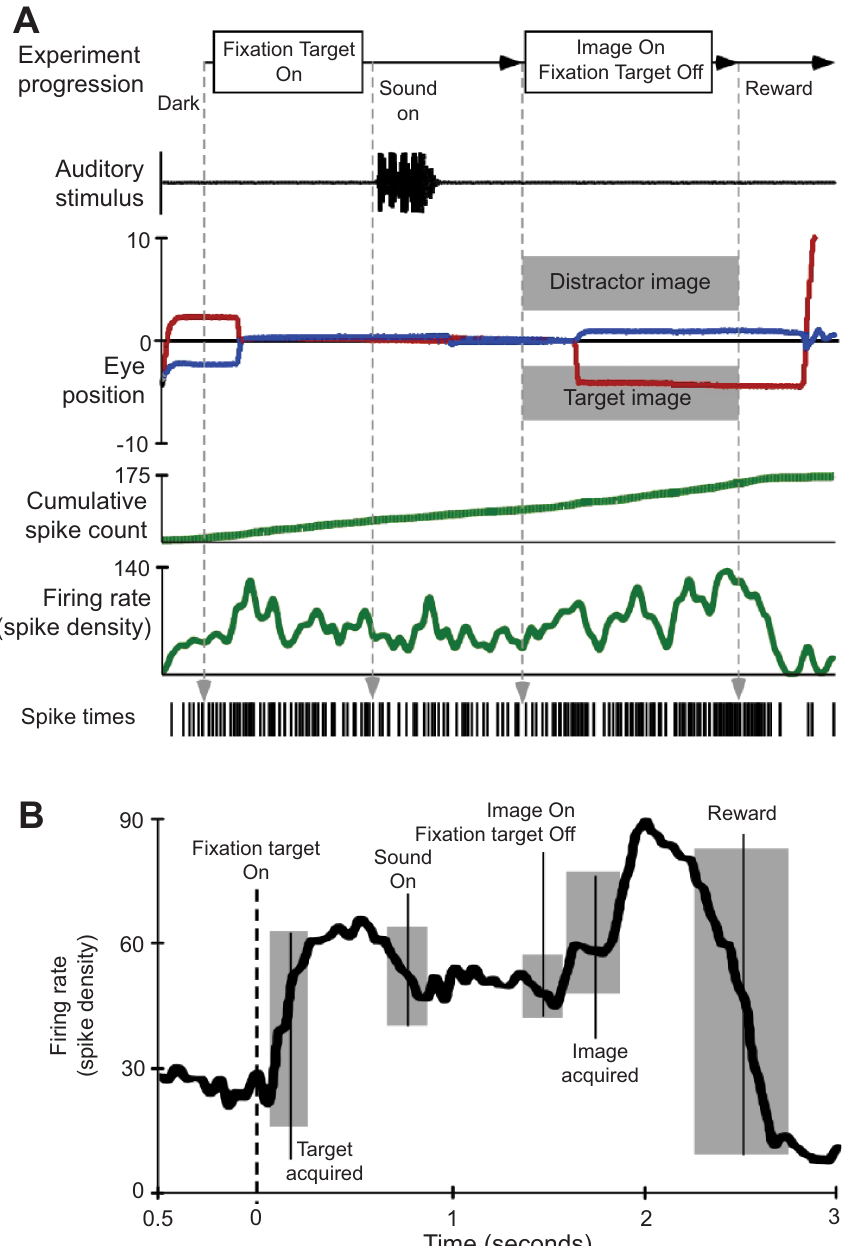
Figure 6. Reward induced neural activity. A . Single experimental trial illustrating stimulus presentation and related neural activity. During these trials, the subject was rewarded for successful discrimination of a sound-associated (target) image and a distractor image. B . Spike density waveform averaged from 20 trials aligned on fixation target onset. All other behavioral and stimulus markers are centered at their average time of occurrence and grey boxes indicate the first standard deviation in event